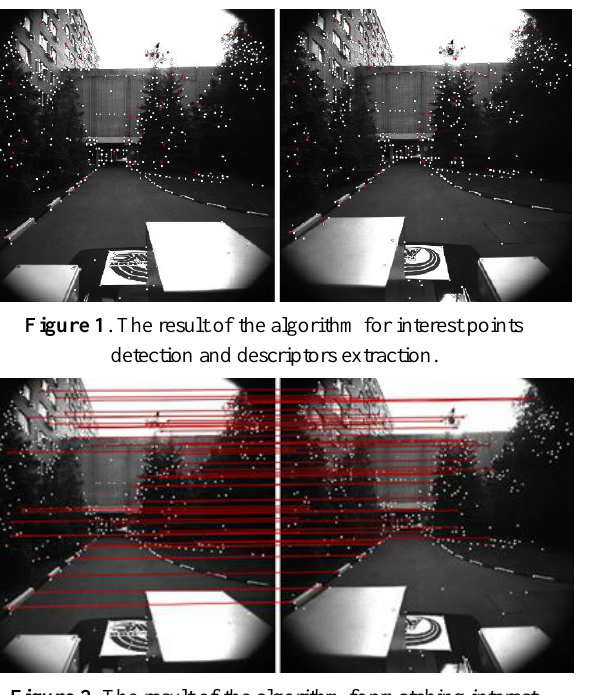
Figure 2 . The result of the algorithm for matching interest points.